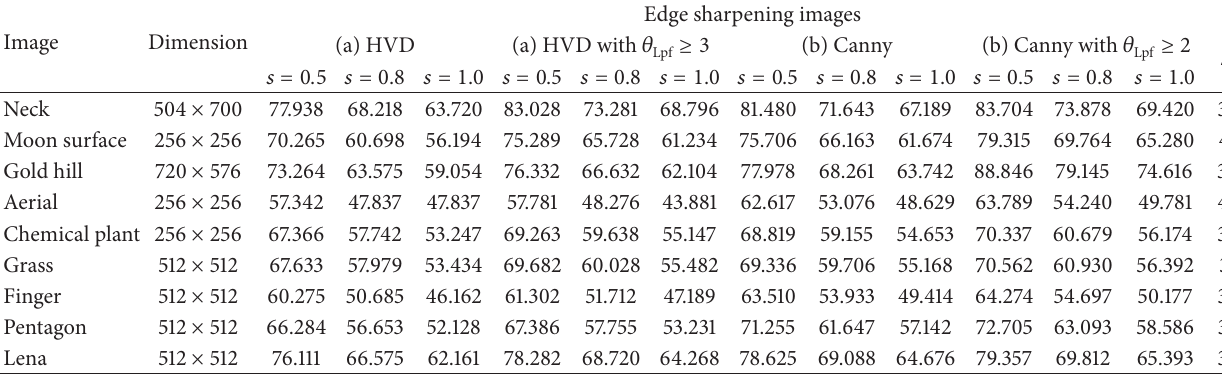
Table 1: Comparisons of the sharpened images with respect to original images in terms of